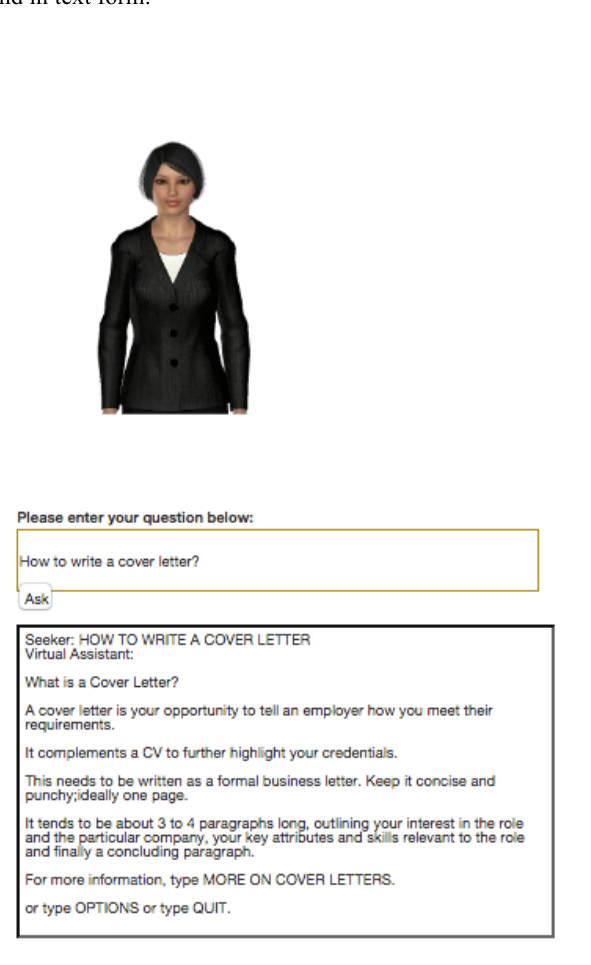
Figure 2. Dialogue with Virtual